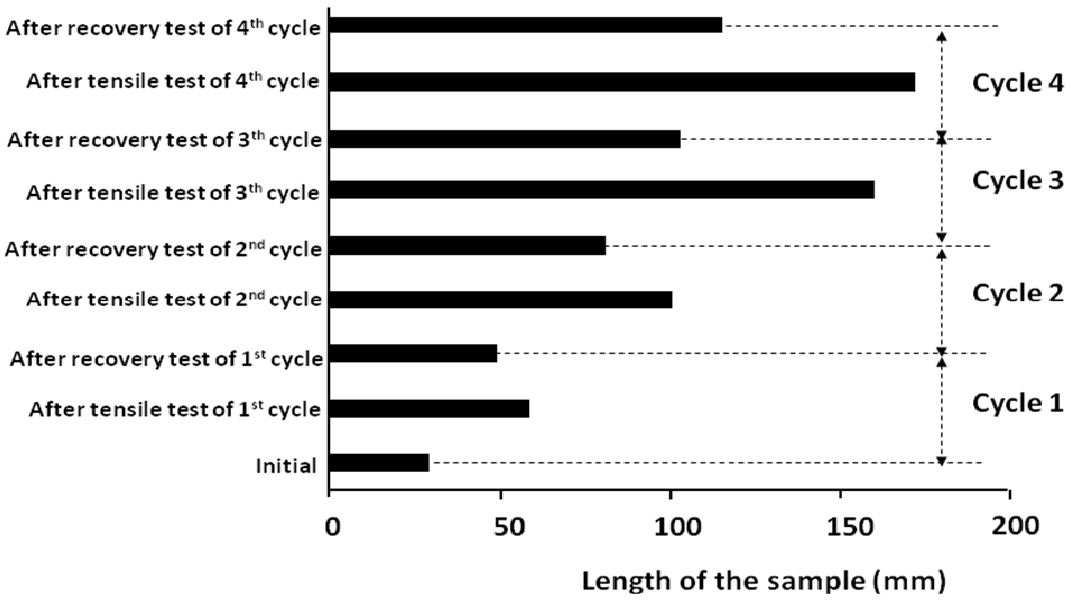
Figure 13. Evolution of shape memory effect (SME) of PLA/PBS by succesive shape memory